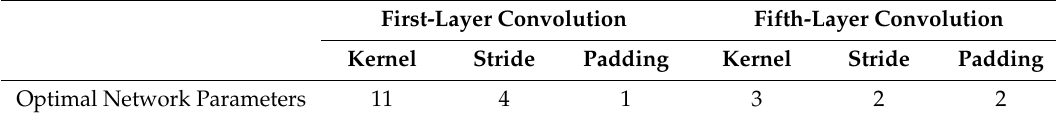
Table 10. The optimal network architecture parameters.